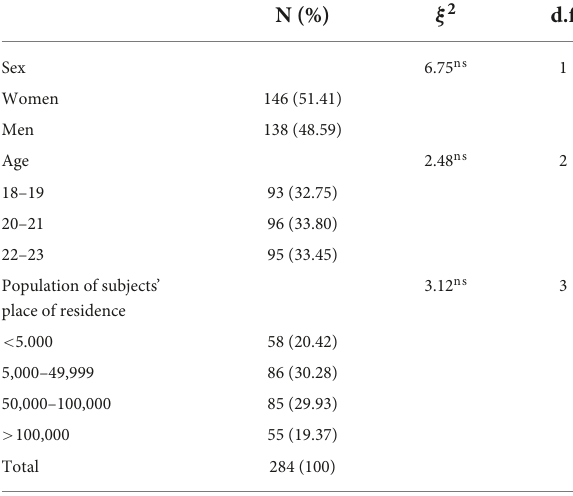
TABLE 1 Sociodemographic data for the Study 1 sample.